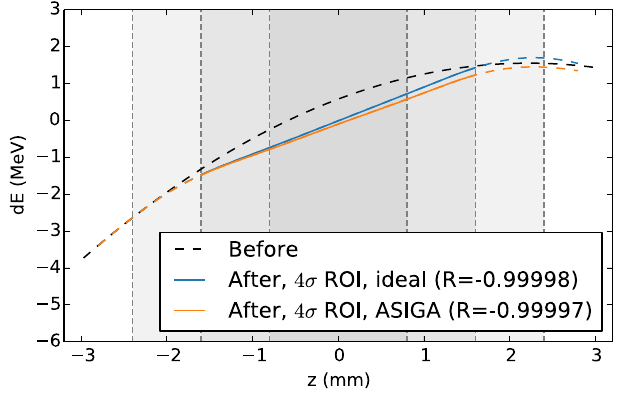
FIG. 14. Comparison of LPSS optimization results for a Gaussian input current profile. The optimization goal was to achieve R ¼ 1 in a 4 σ region of interest. The input beam parameters correspond to WP3 (see Table II). Blue: ideal LPSS; orange: LPSS taking a lateral printing resolution of 27 μ m and a longitudinal printing resolution of 10 μ m into account (as can, for example, be achieved with an ASIGA MAX X27 3D printer).